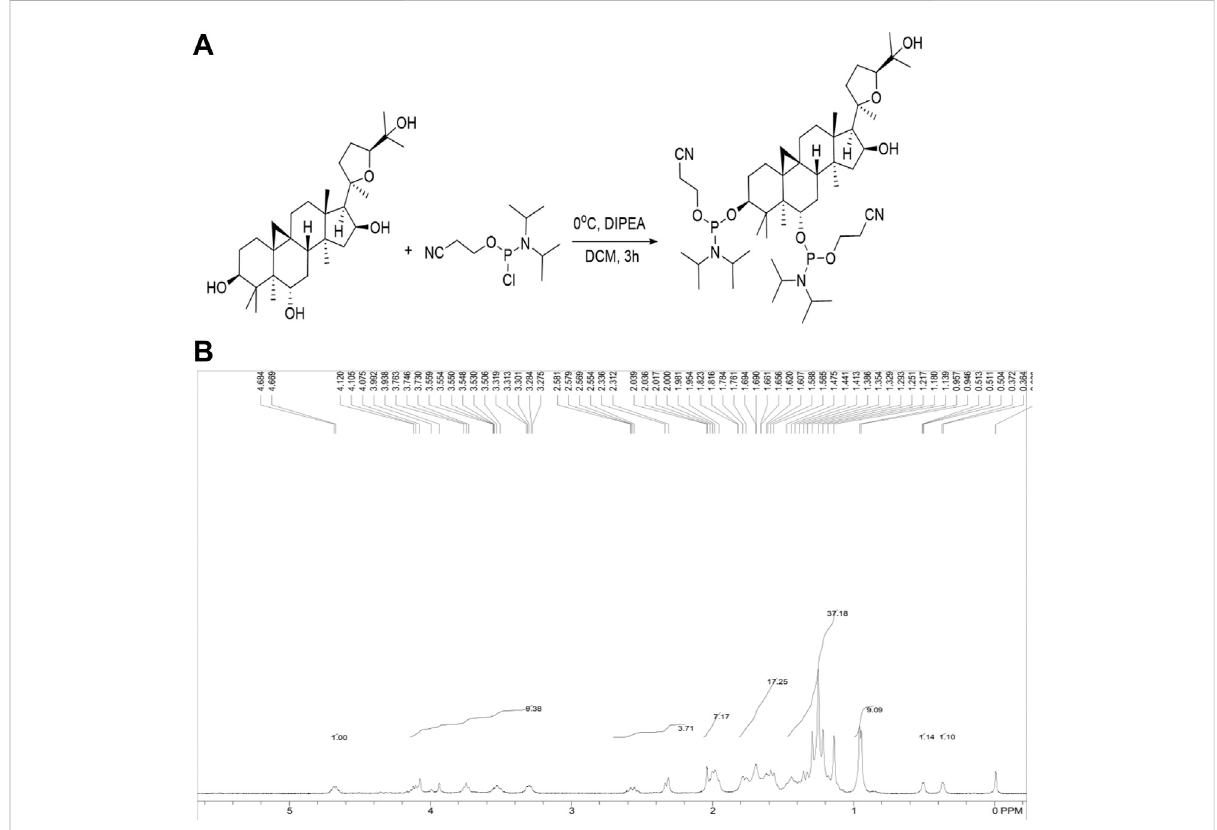
FIGURE 1 (A) SynthesisofCAGphosphoramidite.Underspeci fi cconditionCAGphosphoramiditewassynthesizedbycombiningCAGwith2-cyanoethyl- N, N-diisopropylchlorophosphoramidite. (B) 1 HNMR spectrum of CAG phosphoramidite.